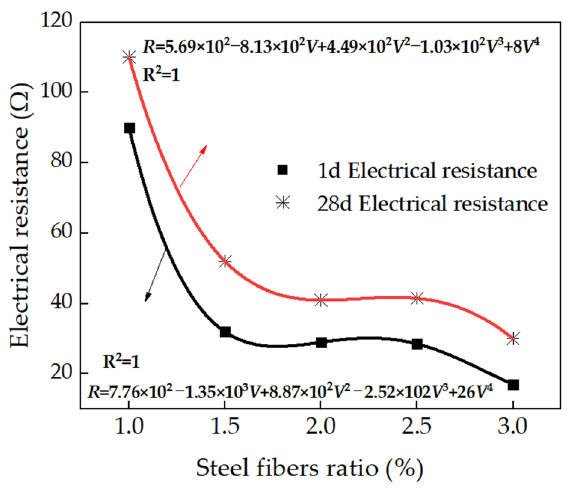
Figure 5. Electrical resistance of steel-fibers-reinforced reactive powder concrete.